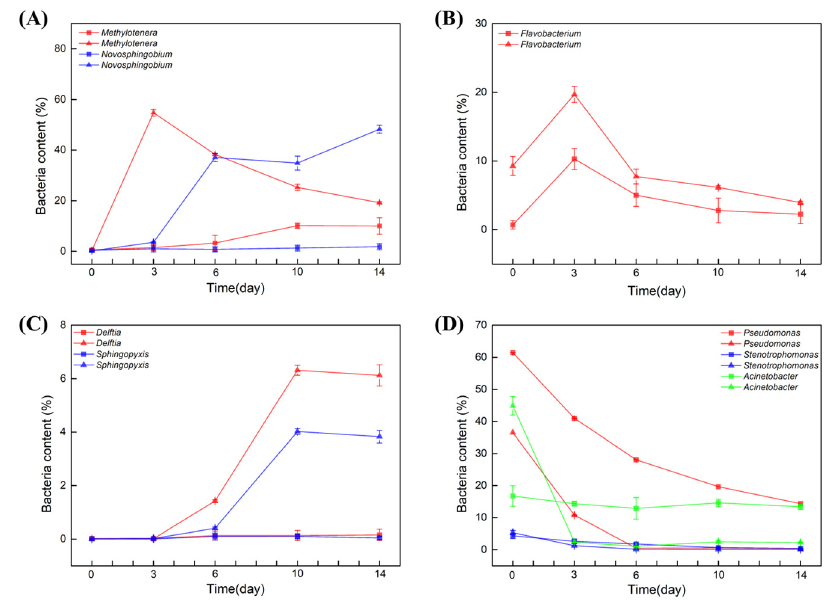
Figure 3. The effect of BBR on bacterial diversity of soil water. Bacterial content within 14 days: Methylotenera and Novosphingobium ( A ), Flavobacterium ( B ), Delftia and sphingopyxis ( C ), Pseudomonas , Stenotrophomonas and Acinetobacter ( D ). Triangular pattern represents BBR degraded samples. Square pattern represents BBR undegraded samples.